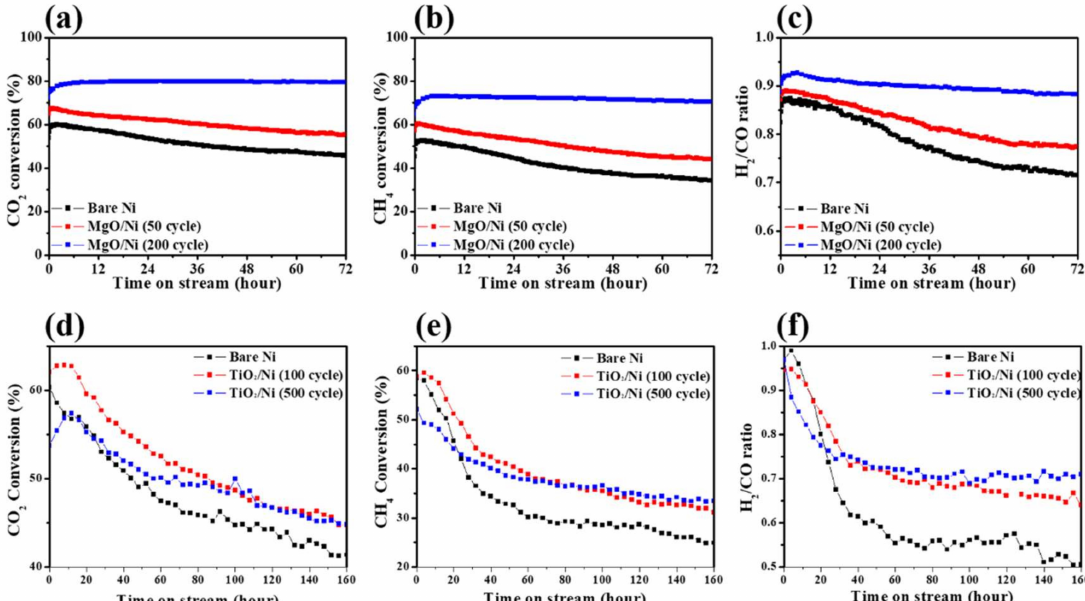
Figure 3. ( a ) CO 2 conversion, ( b ) CH 4 conversion, and ( c ) H 2 /CO ratio, which are products of the DRM reaction, are compared for bare Ni and MgO-wrapped Ni with two different MgO